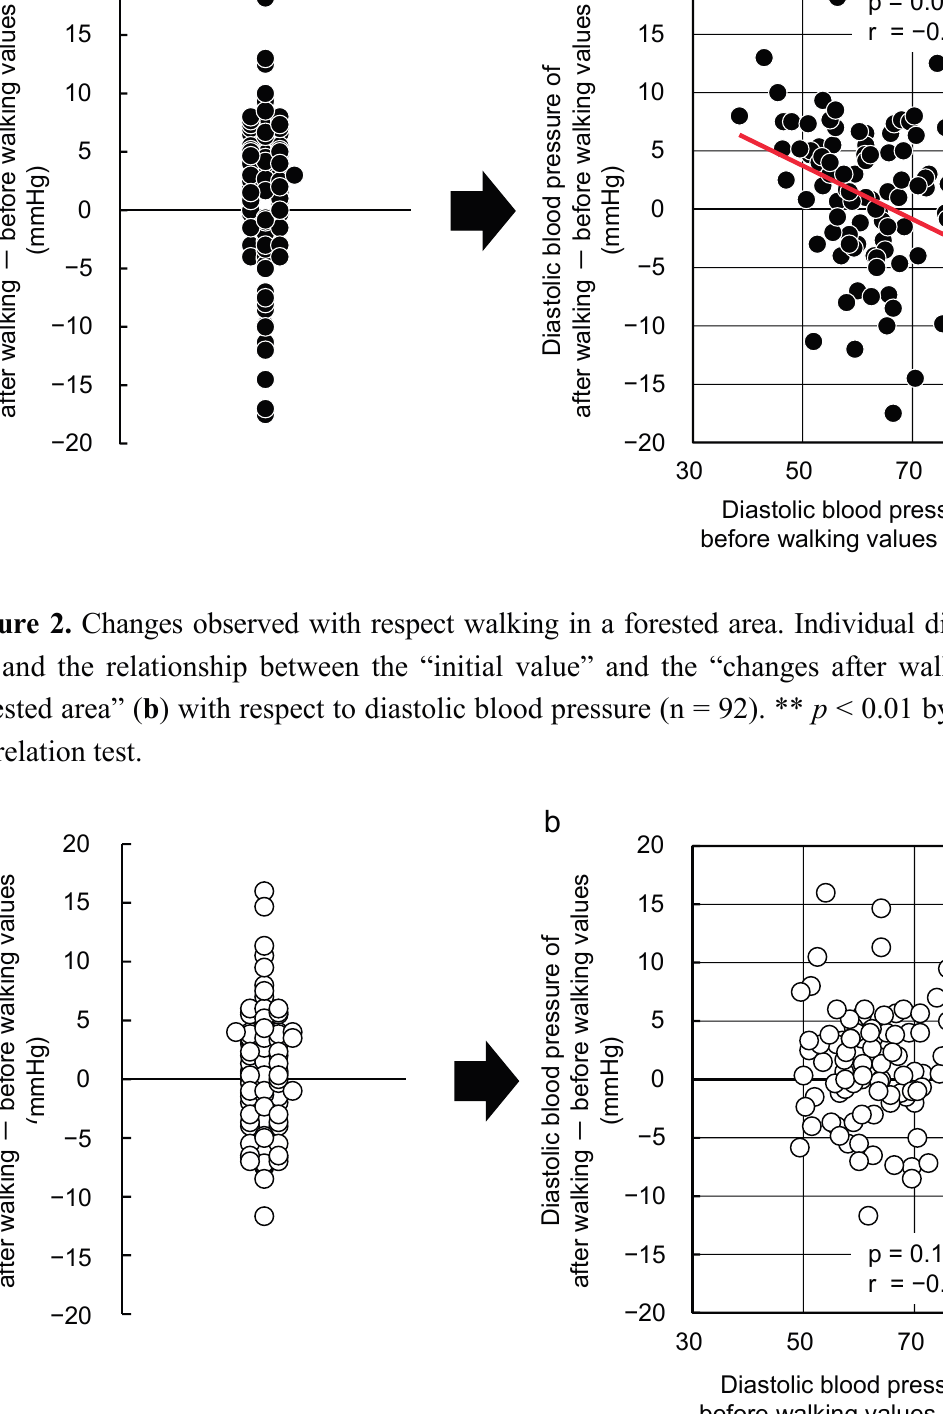
Figure 3. Changes observed with respect walking in an urban area. Individual differences ( a ) and the relationships between the “initial value” and the “changes after walking in an urban area” ( b ) with respect to diastolic blood pressure (n = 92). Pearson correlation